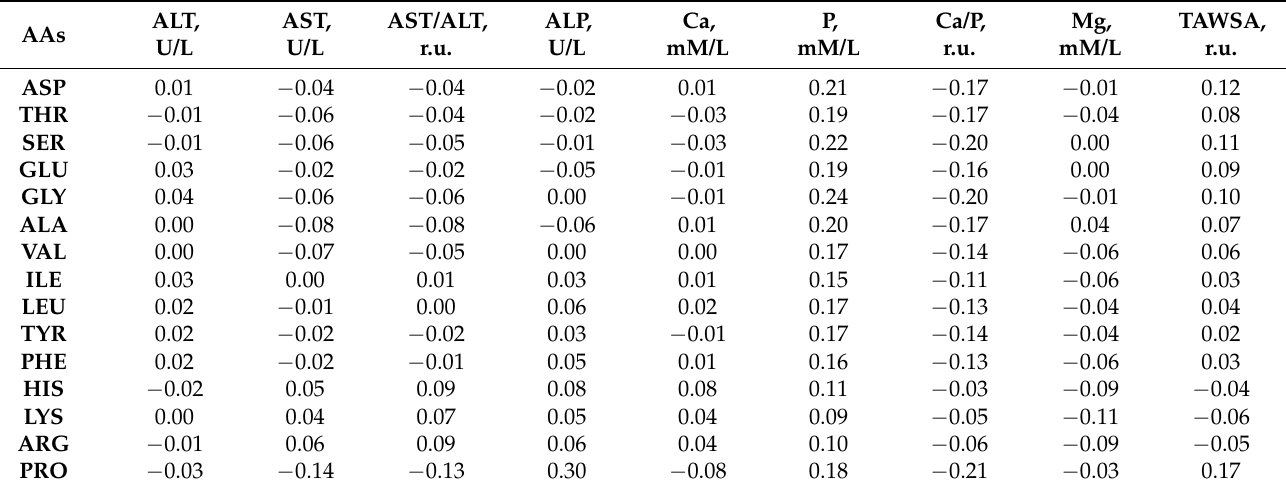
Table 5. The correlation coefficients between all obtained amino acids and the major biochemical parameters of the blood serum of Duroc pigs of the group 2 (72 days): ALT, alanine aminotransferase; AST, aspartate aminotransferase; ALT/AST, alanine to aspartate aminotransferases’ ratio; Ca, calcium; P, phosphorus; Ca/P, calcium to phosphorus ratio; Mg, magnesium; TAWSA, total amount of the water-soluble antioxidants (n = 36).